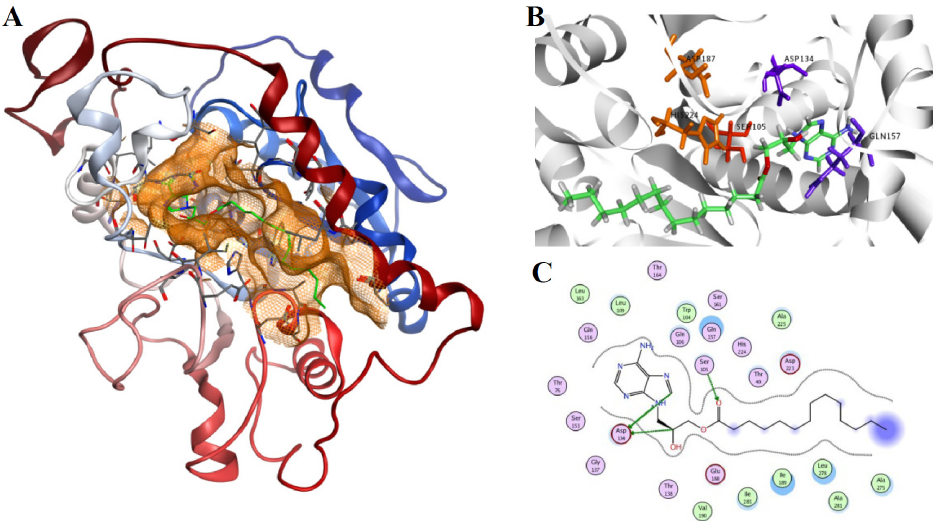
Figure 5. ( A ) The best model of the product 3-(6-amino-9 H -purin-9-yl)-2-hydroxypropyl palmitate ( 2 ) in the active site of CAL-B. This most productive conformation situates the adenine in the large hydrophobic pocket due to a better enzyme–substrate interaction; ( B ) a detail of 2 (represented as green sticks) placement in the binding cavity of the lipase, the catalytic triad Asp-His-Ser is shown as orange sticks (Ser105 is red); ( C ) a schematic view of potential hydrogen-bond stabilisation appearing between: (i) Ser105 and the palmitoyl group, (ii) Asp134 and the 9 ′ H -purin of the adenine ring and 2-OH of propyl. The hydrogen bonds between ligand atoms and amino acids of the active site are shown as dotted lines. Crystal structures with pdb code 1LBS and 1LPP were used.